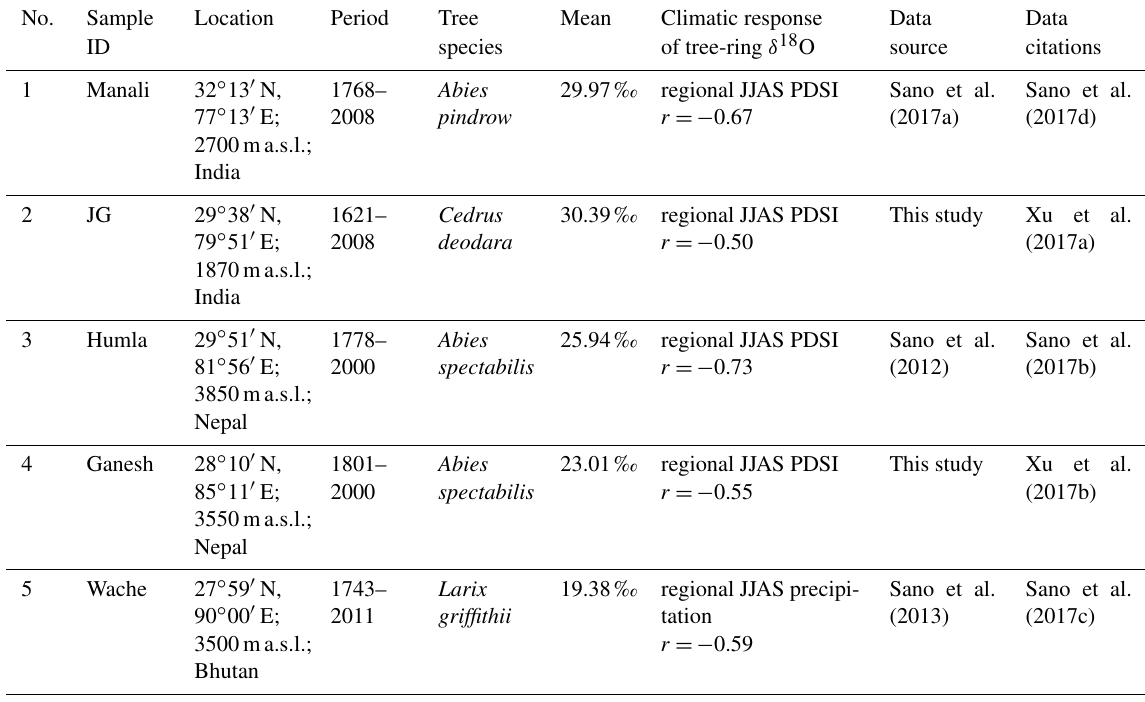
Table 1. Tree-ring cellulose oxygen isotope data sets used in this study. No.